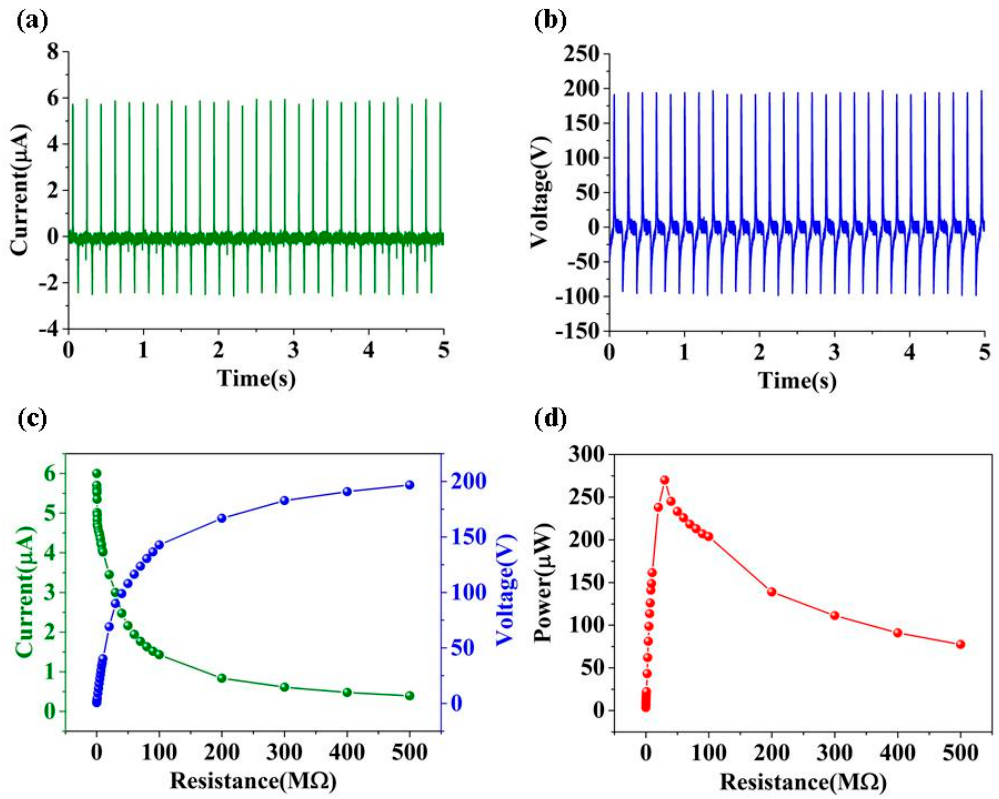
Figure 3. The ( a ) output current, ( b ) voltage of the TENG unit, ( c ) output voltage and current versus different load resistances, and ( d ) corresponding output power density under various load